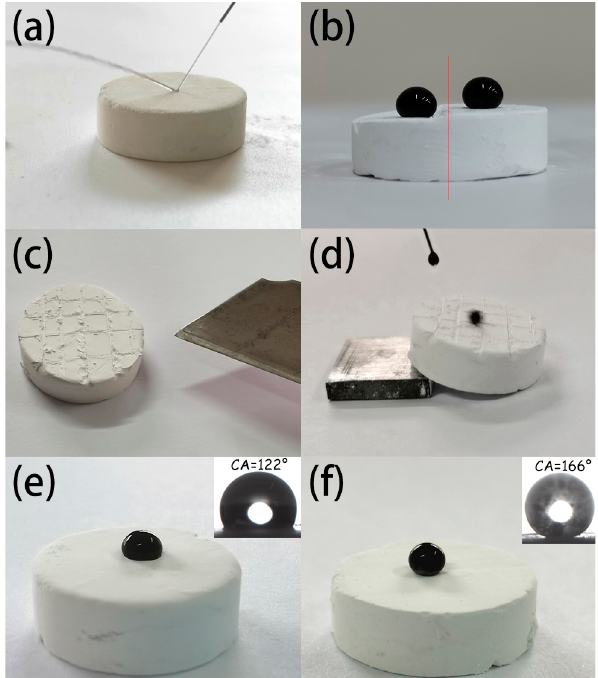
Figure 9. ( a ) Water jet reflection on the superhydrophobic surface. ( b ) Digital photo of water drops on the surface before and after abrasion. ( c ) Digital image of sample scraped by knife. ( d ) Water droplets are rolling off the surface of the sample being scraped. ( e ) Water droplet on the surface of the sample after being contaminated with oil. Inset shows the CA of the contaminated surface is 122°. ( f ) Water droplets on the repaired sample surface. Inset shows the CA of the water droplet on the repaired surface was 166°.